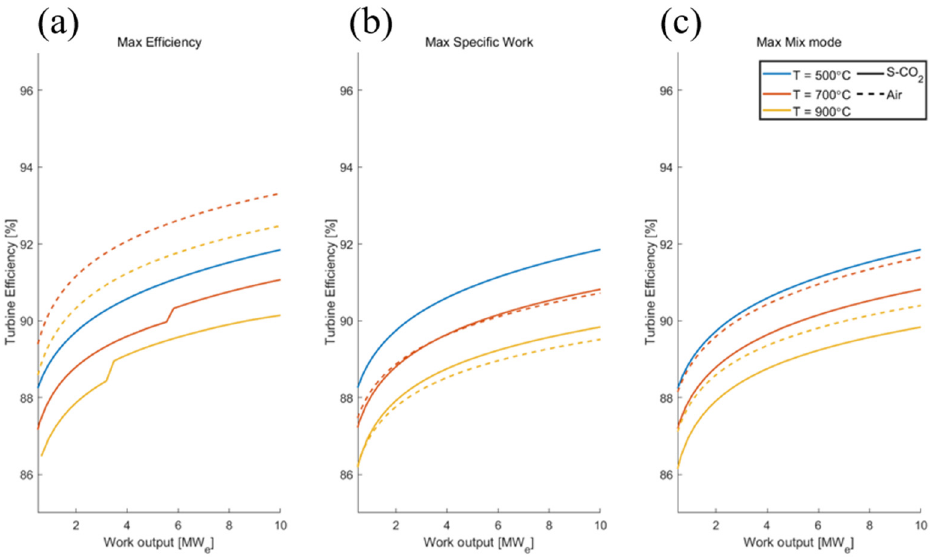
Figure 29. Turbine Efficiency for ( a ) maximum efficiency, ( b ) maximum specific work, and ( c ) maximum mix mode.